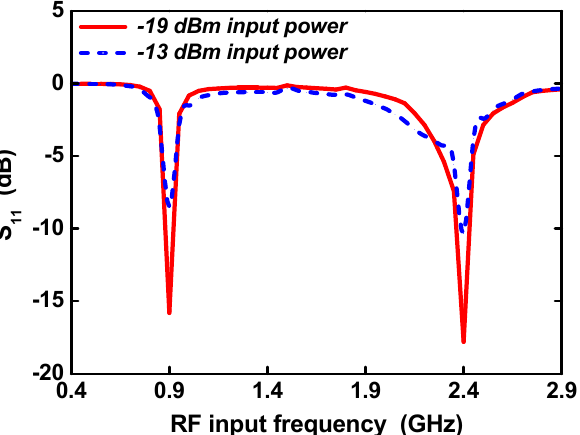
Figure 13. Reflection coefficient ( S 11 ) versus RF input frequency at different input powers.